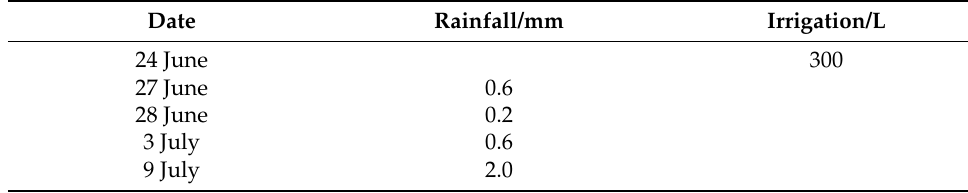
Table 2. Rainfall and irrigation during the experiment.